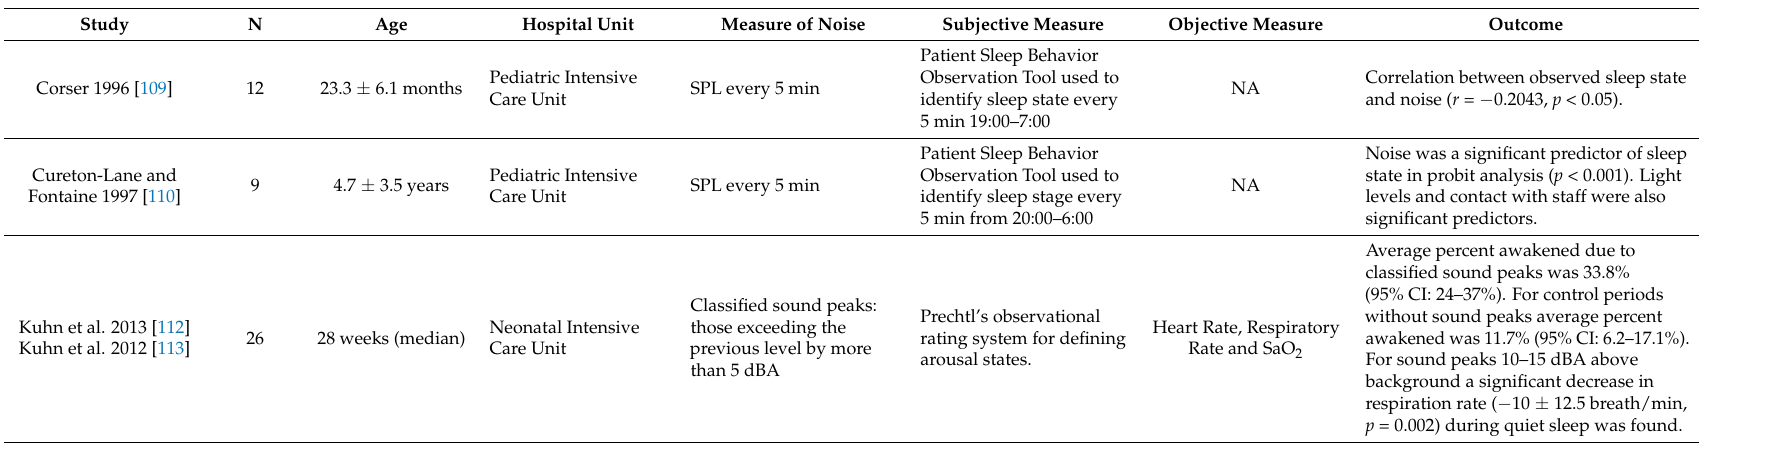
Table 9. Characteristics of studies on hospital noise and sleep in